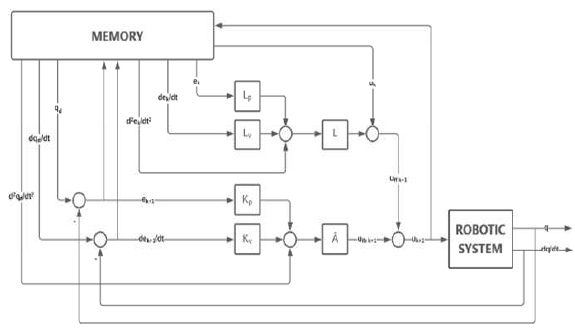
Figure 1b. Block diagram of BEAILC and COILC